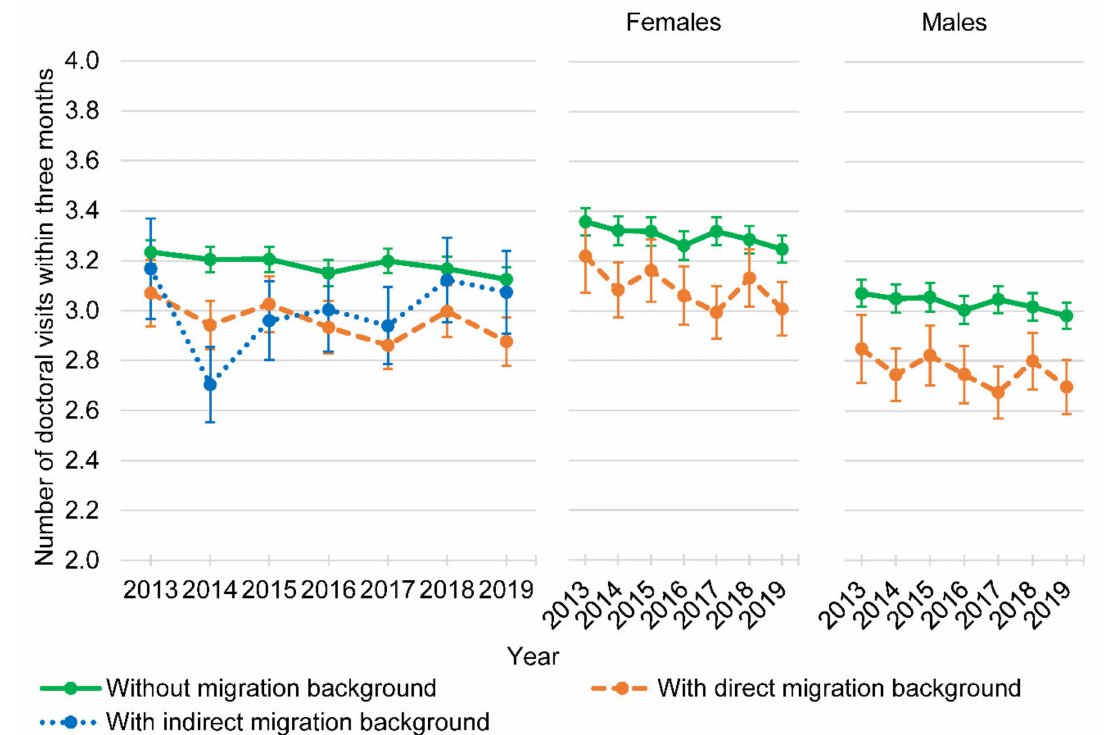
Figure 2. Adjusted zero-truncated number of doctoral visits within three months of persons without and with direct/indirect migration background, and of females and males without and with direct migration background (years 2013 to 2019, n = 31,052; 127,799